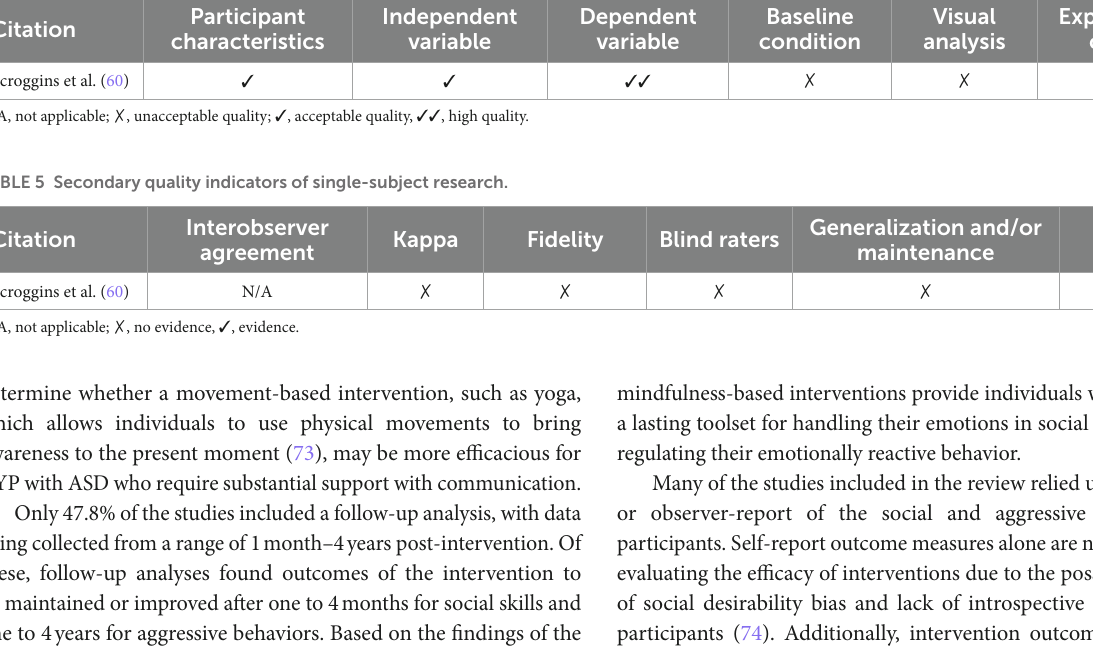
TABLE 4 Primary quality indicators of single-subject research. Citation